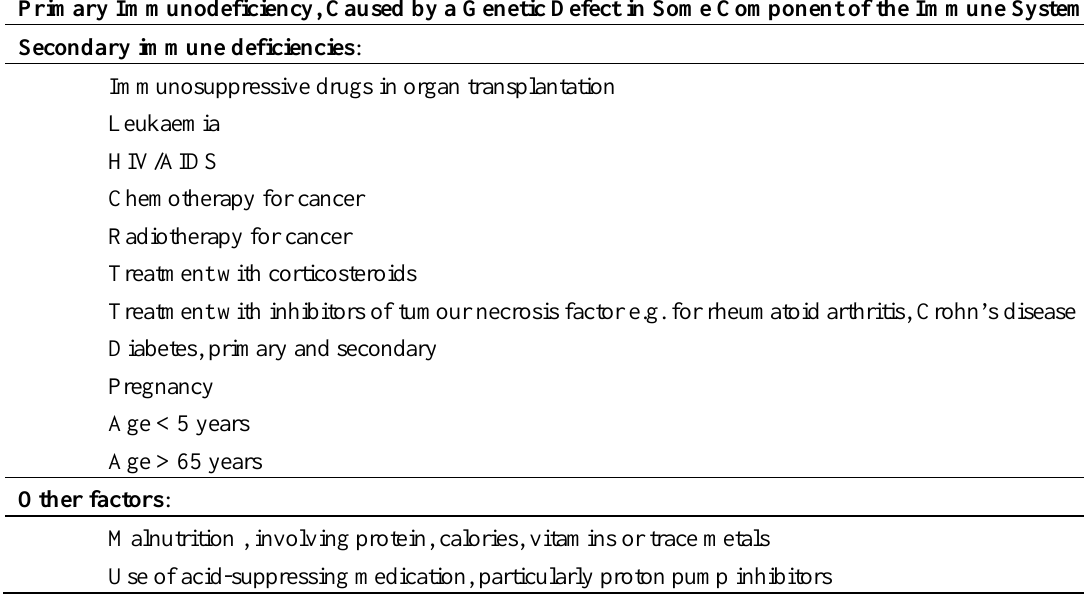
Table 4. Host factors that lead to increased susceptibility to foodborne infection and increased severity of illness.